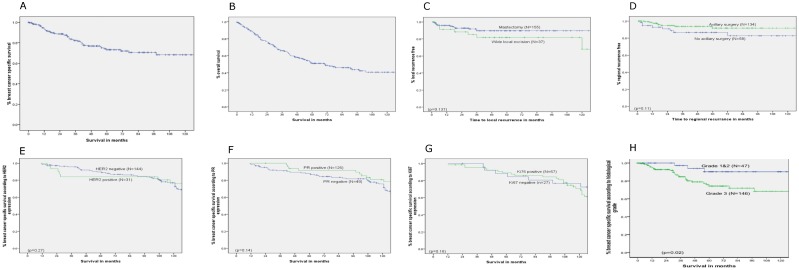
Kaplan-Meier plots of time-dependant outcome variables in older women with ER-negative early operable primary breast cancer.(A) Breast cancer specific survival of Oestrogen receptor negative early operable primary breast cancer in older women. (B) Overall survival of Oestrogen receptor negative early operable primary breast cancer in older women. (C) Local recurrence free survival of Oestrogen receptor negative early operable primary breast cancer in older women- Mastectomy versus wide local excision. (D) Regional recurrence free survival of Oestrogen receptor negative early operable primary breast cancer in older women- Axillary surgery versus no axillary surgery. (E) Breast cancer specific survival of Oestrogen receptor negative early operable primary breast cancer in older women- Progesterone Receptor (PR) positive versus negative. (F) Breast cancer specific survival of Oestrogen receptor negative early operable primary breast cancer in older women- Human Epidermal Growth Factor Receptor– 2 (HER2) positive versus negative. (G) Breast cancer specific survival of Oestrogen receptor negative early operable primary breast cancer in older women- Ki67 positive versus negative. (H) Breast cancer specific survival of Oestrogen receptor negative early operable primary breast cancer in older women- Low (ie 1–2) Grade versus high (ie 3) Grade.